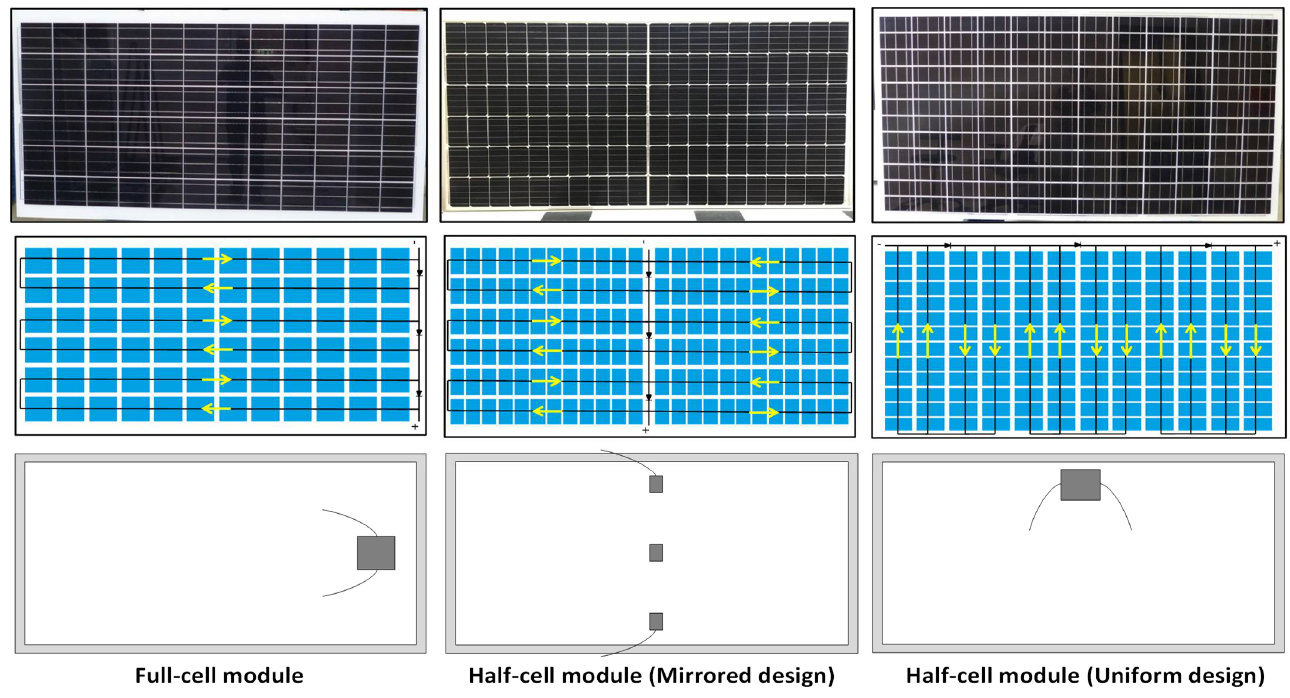
Figure 10. Module picture, interconnection schematics and rear-side shematics of the full-cell module, half-cell module with mirrored design and half-cell module with uniform design (adapted with permission from [66]).